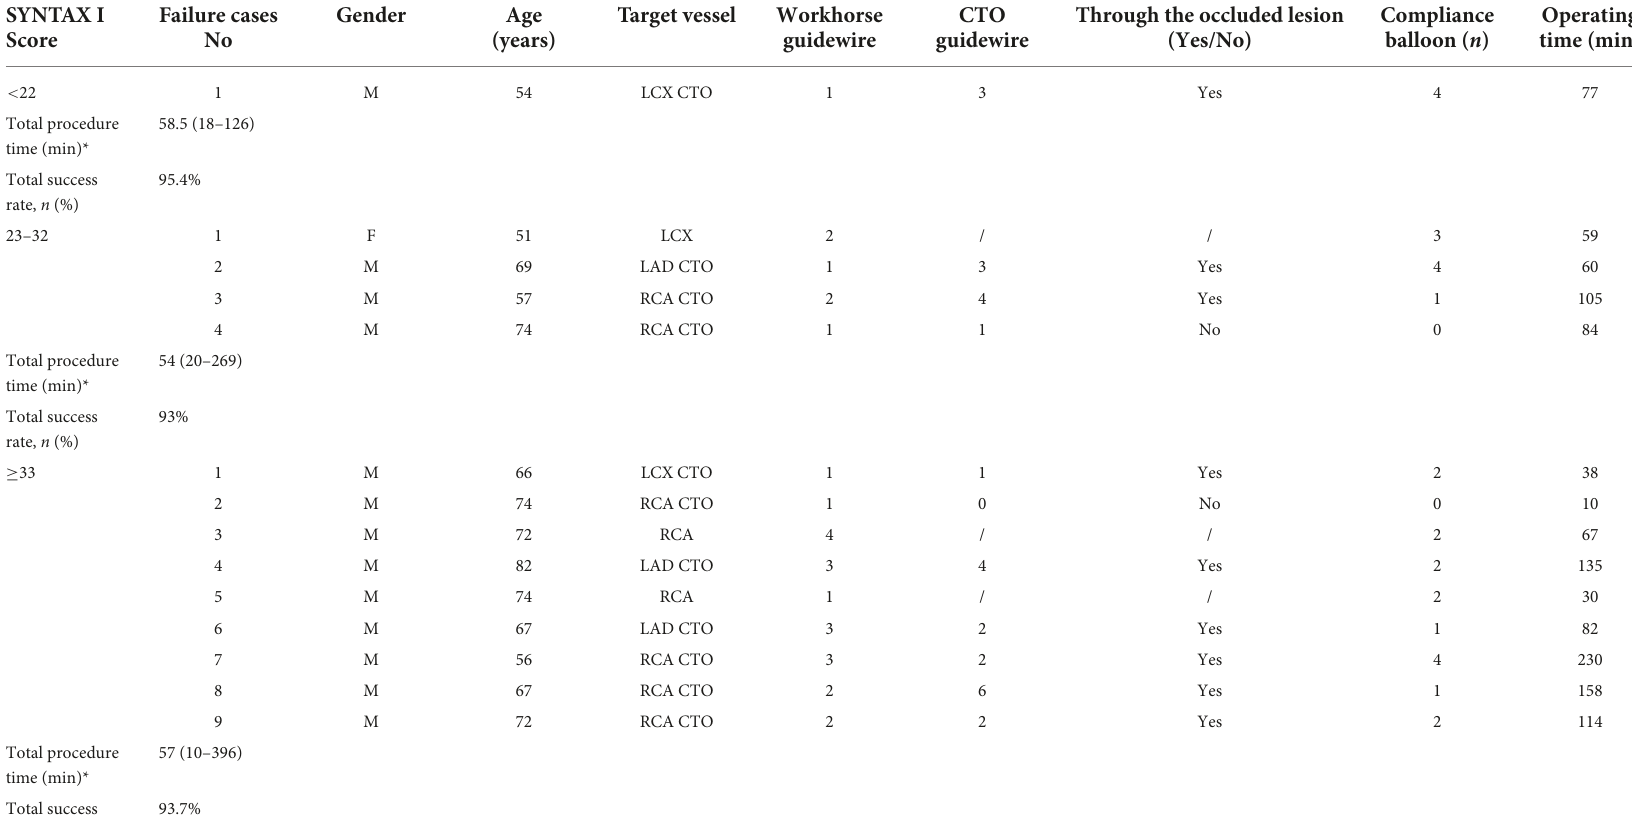
TABLE 4 Analysis of failure cases who underwent TRI using GGEC I according to SYNTAX I Score ( n =